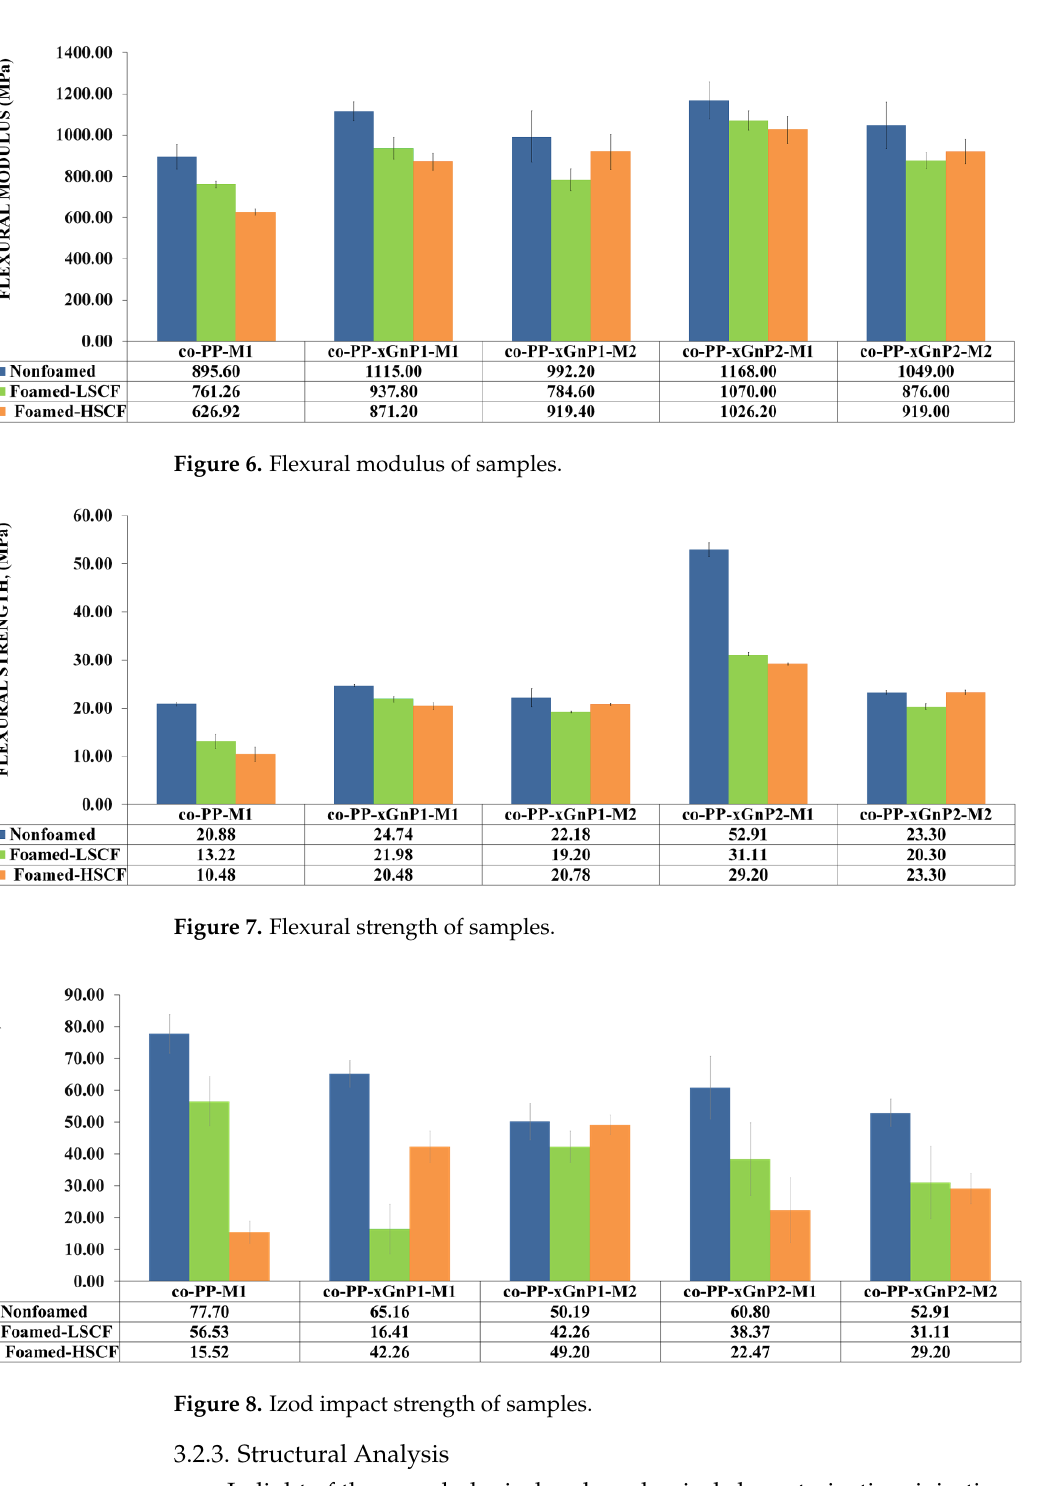
Figure 6. Flexural modulus of samples.